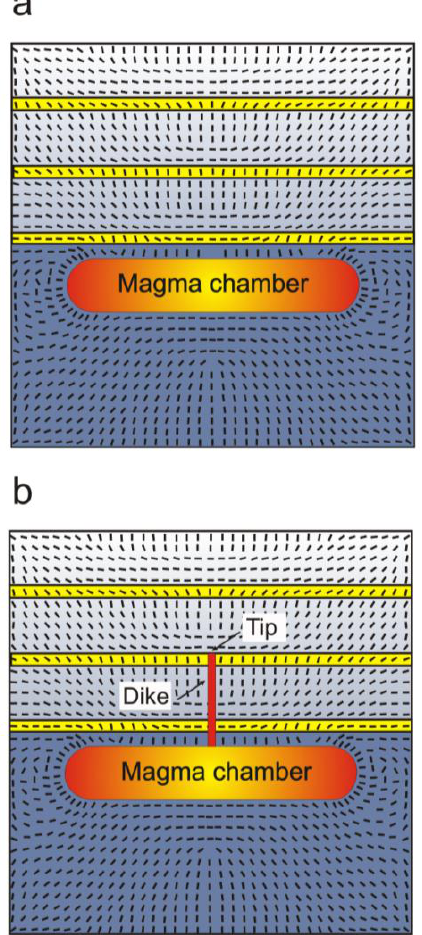
Fig. 6. Dike arrest due to principal stress rotation at contacts be- tween dissimilar rocks. In this finite-element model, the only load- ing is magmatic excess pressure (5MPa) in the magma chamber, lo- cated in a layer with a stiffness of 40GPa. The thick (light blue) and thin (yellow) layers have stiffnesses of 100GPa and 1GPa, respec- tively. The direction of the principal compressive stress, σ 1 , is indi- cated by ticks (short lines). (a) State of stress before dike injection. (b) The dike follows the σ 1 -ticks and, depending on its overpres- sure and the elastic mismatch (Fig. 9) across the contact, becomes arrested (as seen here) or changes into a sill (Figs. 7 and 10).